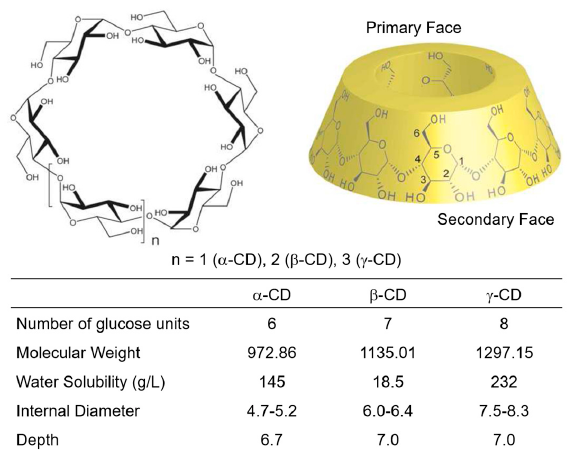
Figure 6. Structures of cyclodextrins (CDs). Reprinted with permission from ref. [66]. Copyright 2008 MDPI.